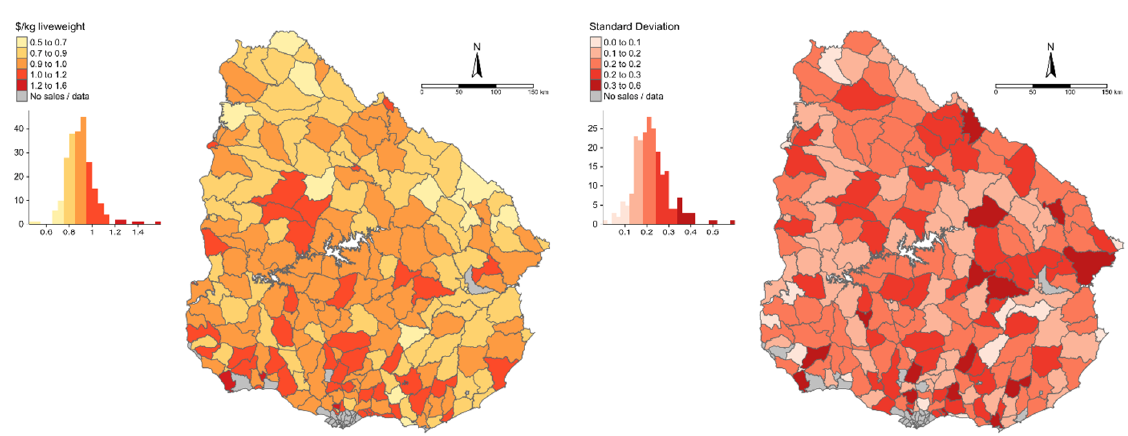
Figure 1. Mean and standard deviation of cattle price using the decimated data set ( N = 2845), each given with k -means breaks.